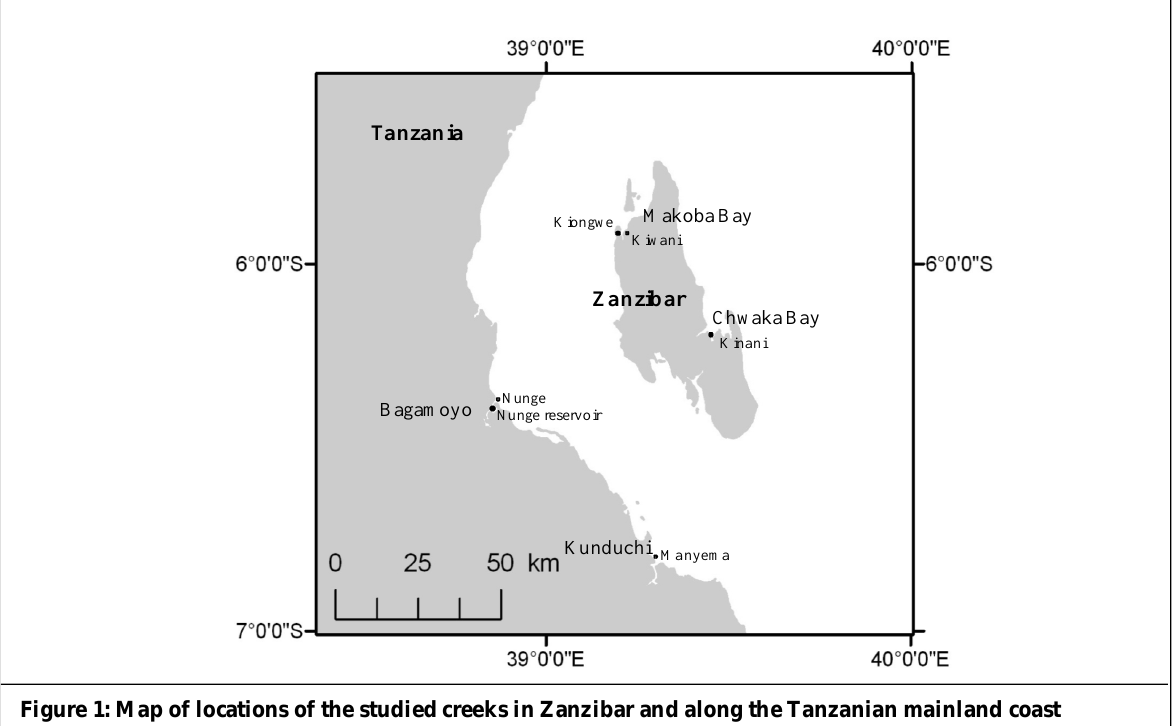
Figure 1: Map of locations of the studied creeks in Zanzibar and along the Tanzanian mainland coast